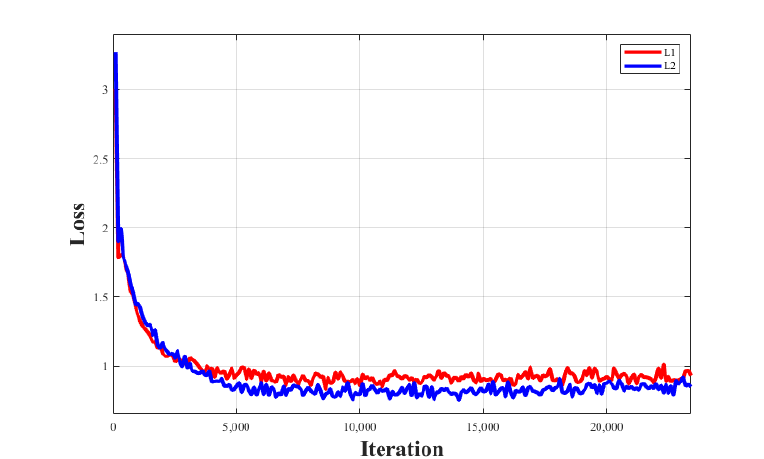
Figure 6. Using L1 and L2 paradigms alone.